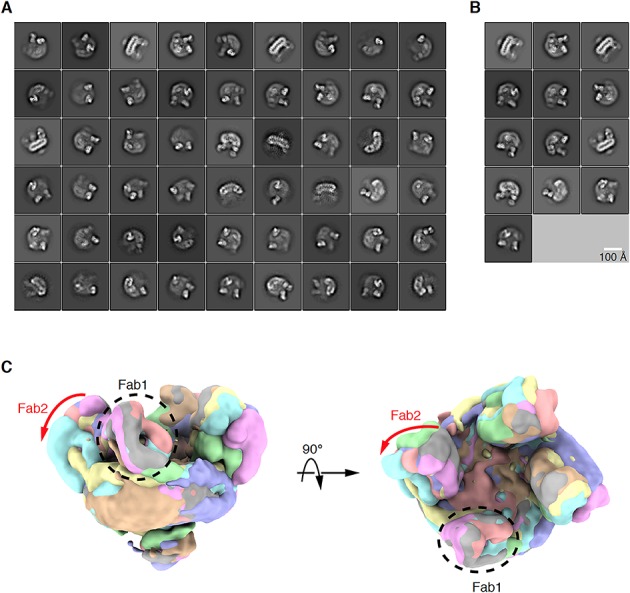
Positional variability of the Fabs.(A) 2D class averages of all the particles after removing false positives. (B) 2D class averages of the particles used for initial model generation. (C) Overlay of the eight classes after first round of 3D classification showed variation in Fab orientation.